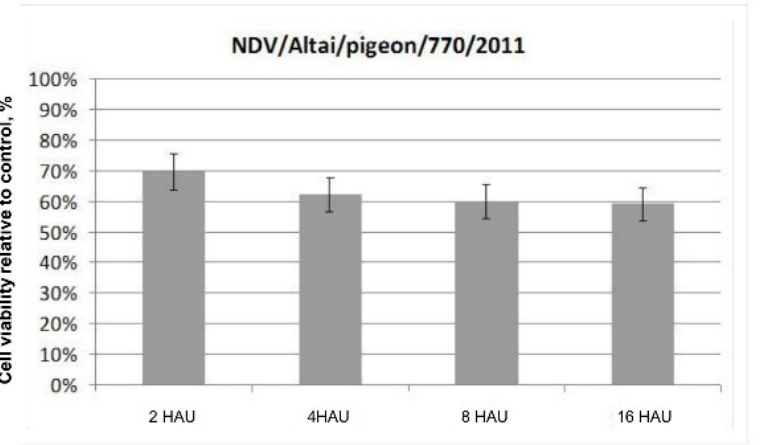
Figure 1. Cytotoxic effect of the wild-type NDV strain NDV/Altai/pigeon/770/2011 on mouse Krebs-2 ascites carcinoma cells on day 4 after infection, doses of 2, 4, 8, and 16 HAU per 10,000 cells, MTS assay.